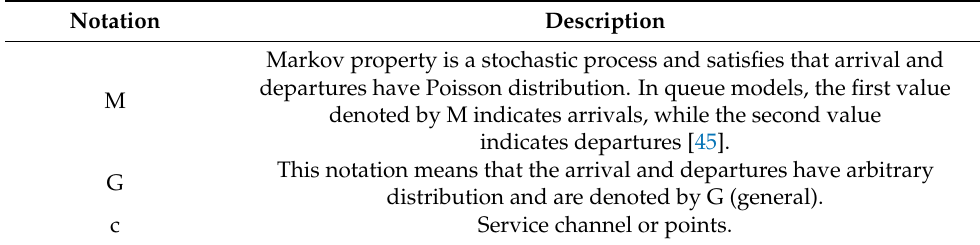
Table 2. Definitions of the terms used by queue